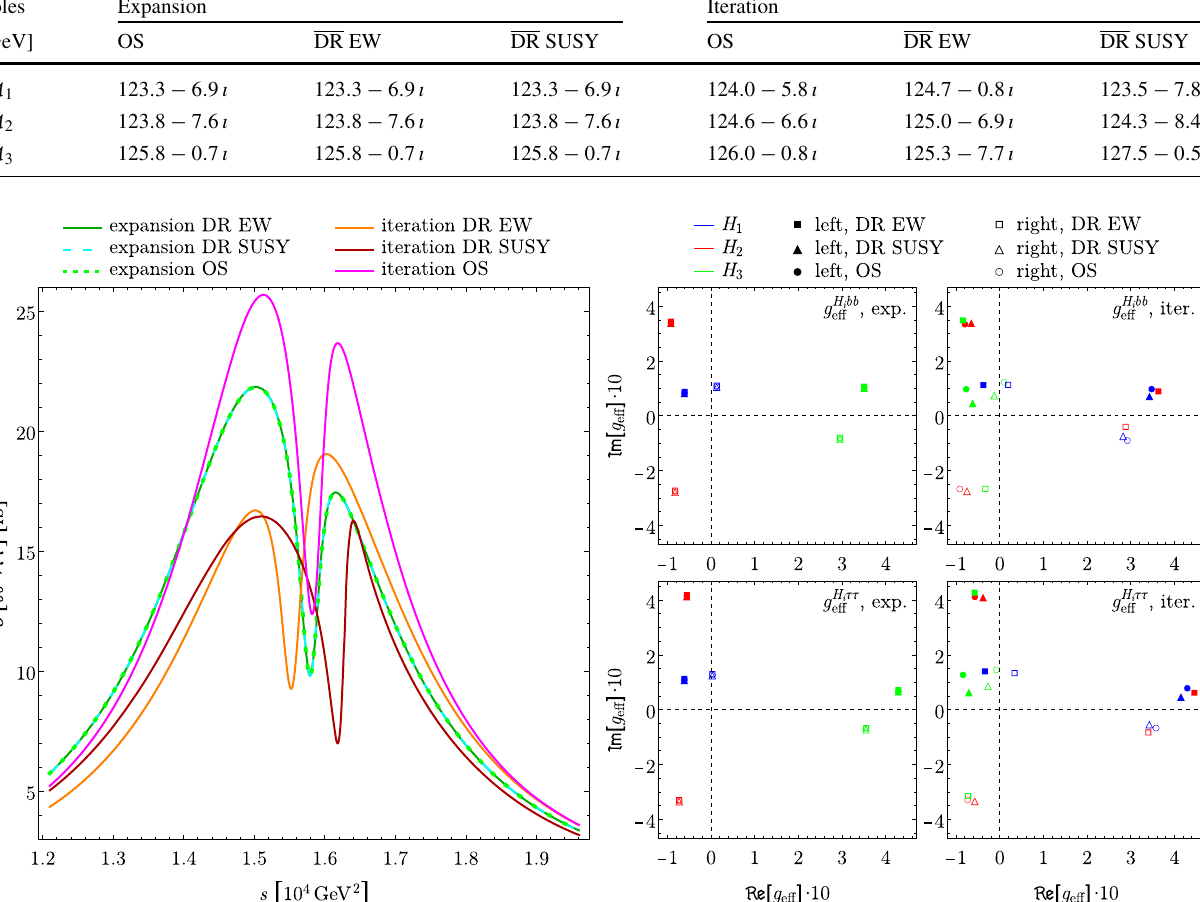
respectively). Right: effective Higgs couplings to bottom quarks (upper row) and τ leptons (lower row) obtained in the expansion (left column) and in the iterative approaches (right column). Left- and right-handed couplings are depicted in the complex plane with filled and empty sym- bols